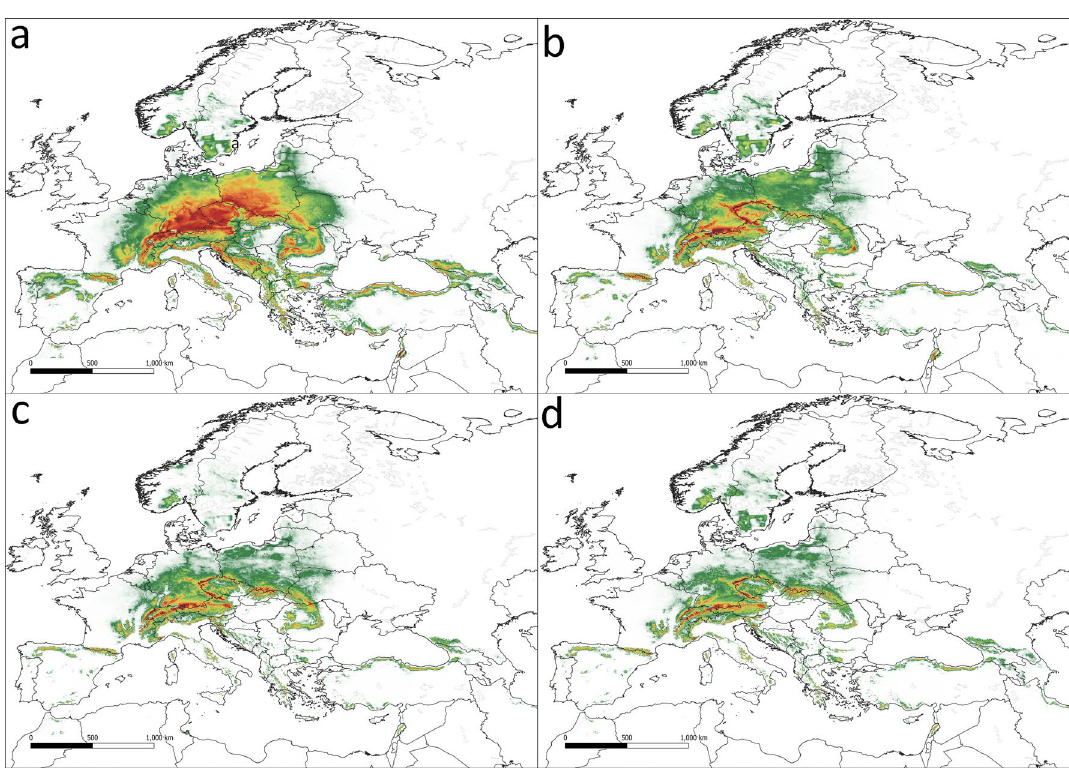
Figure 3. The potential range of Viscum album subsp. abietis . ( a ) current conditions, ( b ) scenario SSP 1.26, ( c ) scenario SSP 3.7, ( d ) scenario SSP